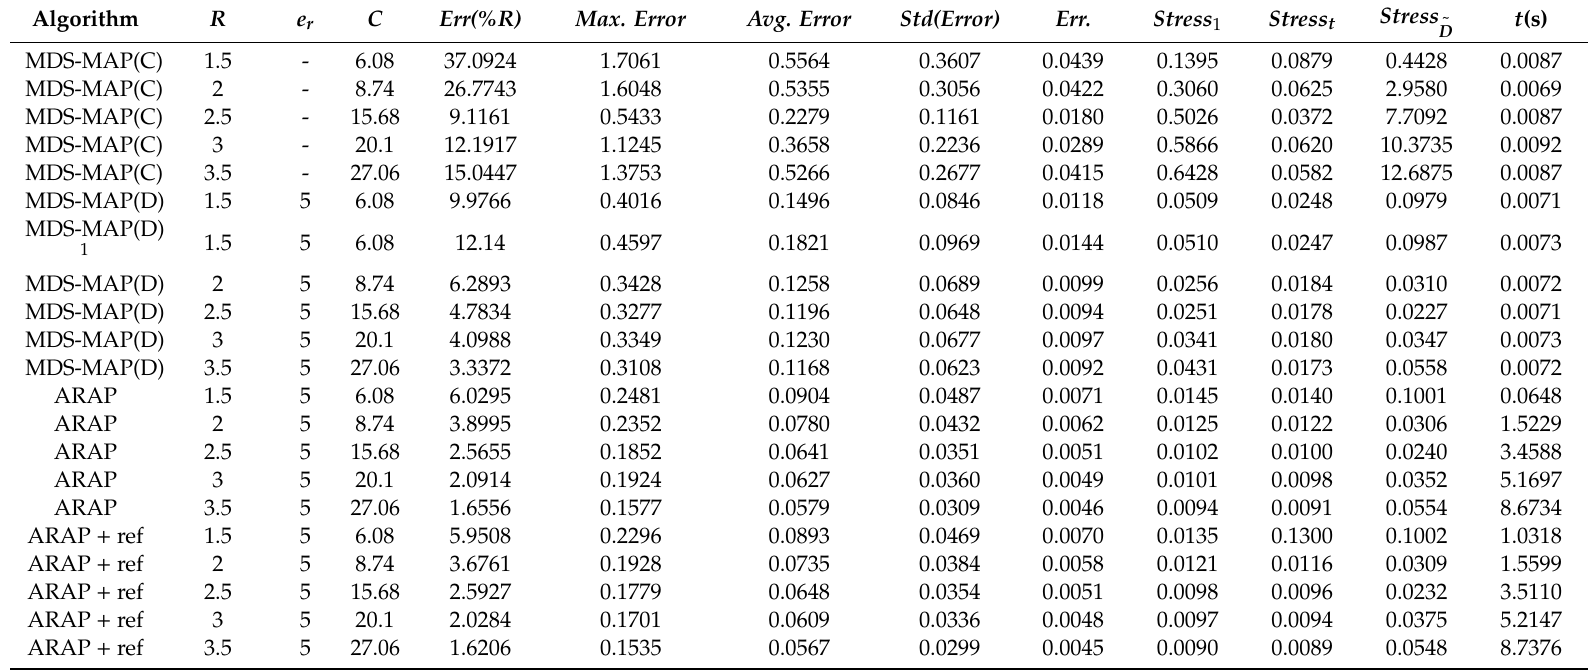
Table 1. Monte-Carlo simulations for 100 nodes uniformly distributed in a 10 r · 10 r grid. Three anchor nodes, e p =